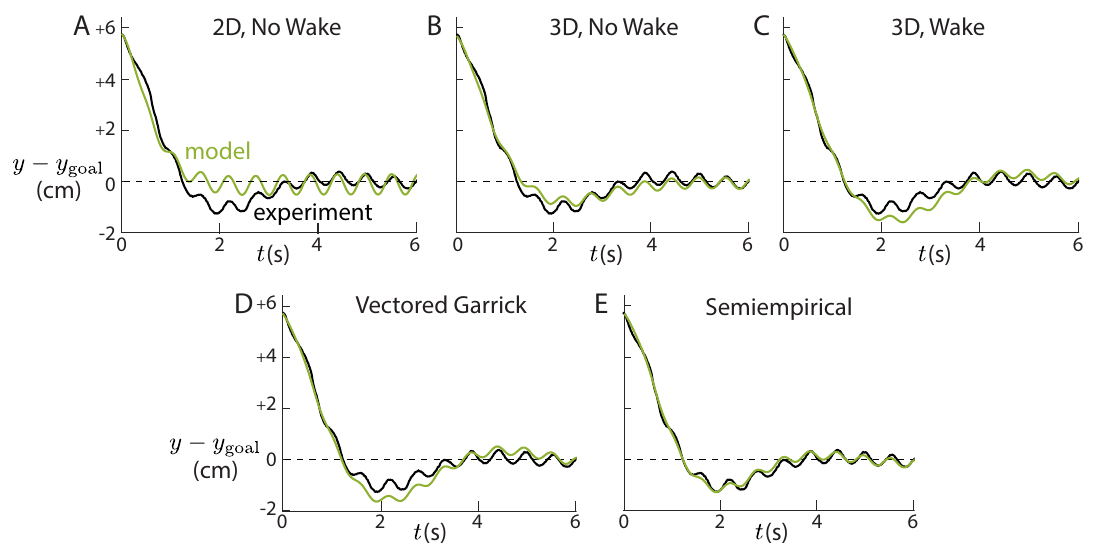
Figure 5. Predictions of lateral position vary between models. The case shown ( St = 0.3) demonstrates typical variation between the models. The models which include the wake and 3D corrections (3D, Wake, C ; Vectored Garrick, D ; Semiempirical, E ) capture the high frequency heaving motion better than the models without both the wake and 3D corrections (2D, No Wake, A ; 3D, No Wake, B ). Only the semiempirical model accurately predicts both the low and high frequency